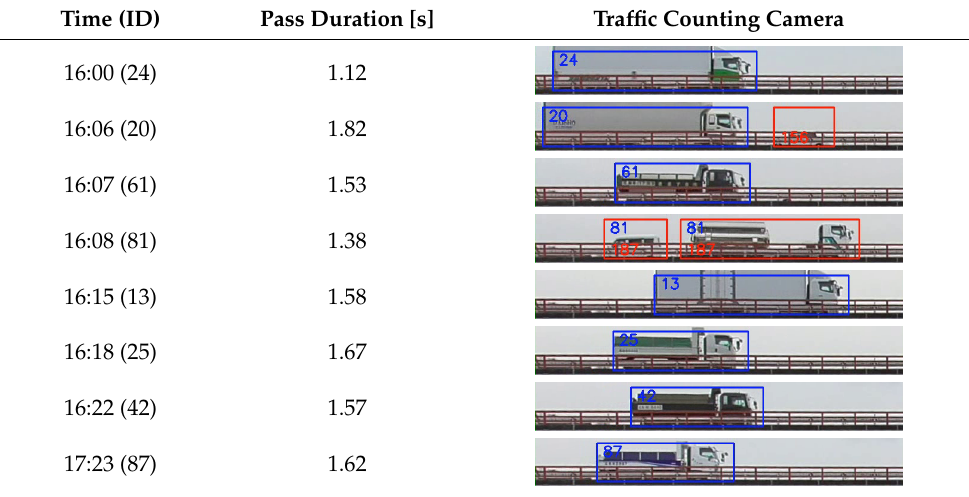
Table A1. Passes with large displacement (>2.5 mm). The listed duration represents the duration when differential displacement larger than set 2.5 mm was continuously observed throughout the pass. Small vehicle passes during such duration were being misdetected as having large